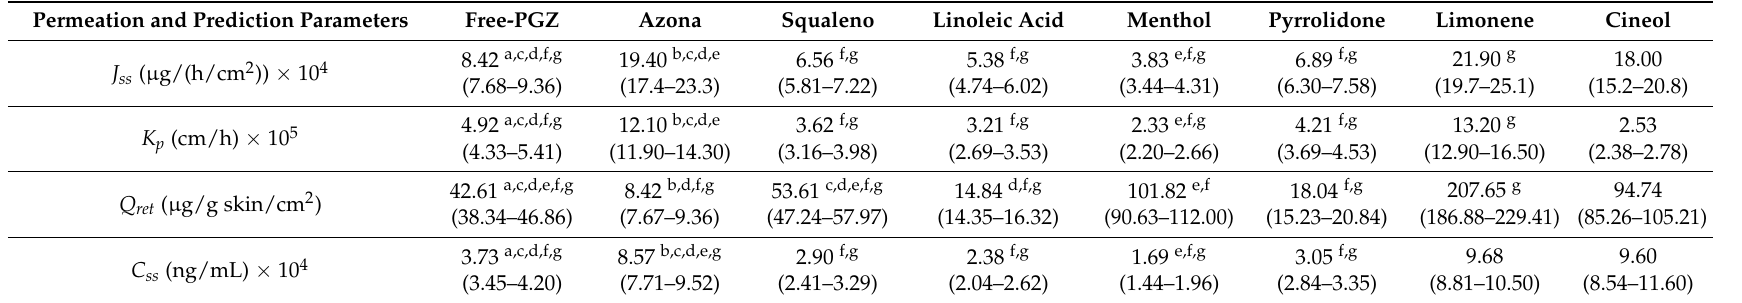
Table 1. Permeation and prediction parameters of PGZ and penetration